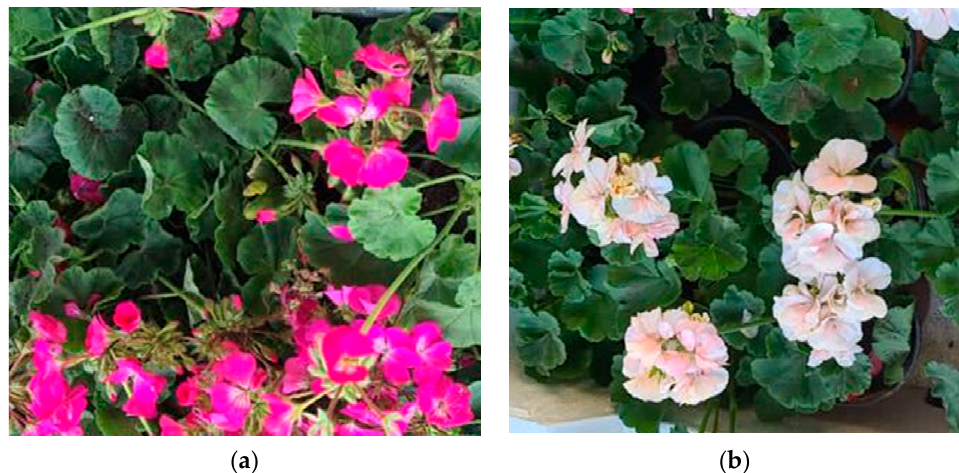
Figure 1. Pelargonium × hortorum (PH) cultivars; ( a ) with pink flowers (PPH); ( b ) with white-to-rose flowers (WPH).